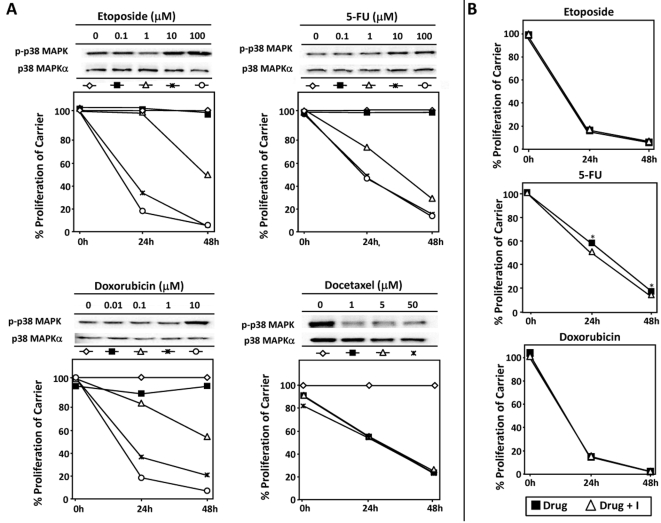
The cytotoxic effects of etoposide, 5-fluorouracil, doxorubicin, and docetaxel are not associated with p38 MAPK activation in LLC11 cells.A) The effect of increasing concentrations of etoposide, 5-FU, doxorubicin or docetaxel on p38 MAPK activation and proliferation were assessed by immunoblotting and MTS assay respectively. B) The effect of p38 MAPK blockade on drug-induced cytotoxicity in LLC1 cells treated with etoposide, 5-FU or doxorubicin. Note that the addition of the p38 MAPK inhibitor appeared to enhance the cytotoxic effects of 5-FU on LLC1 cells (see *).